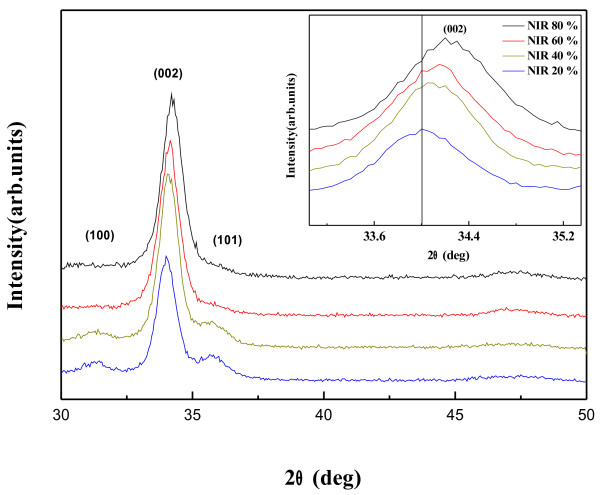
The XRD scans with CuKα radiation for AZO thin films.